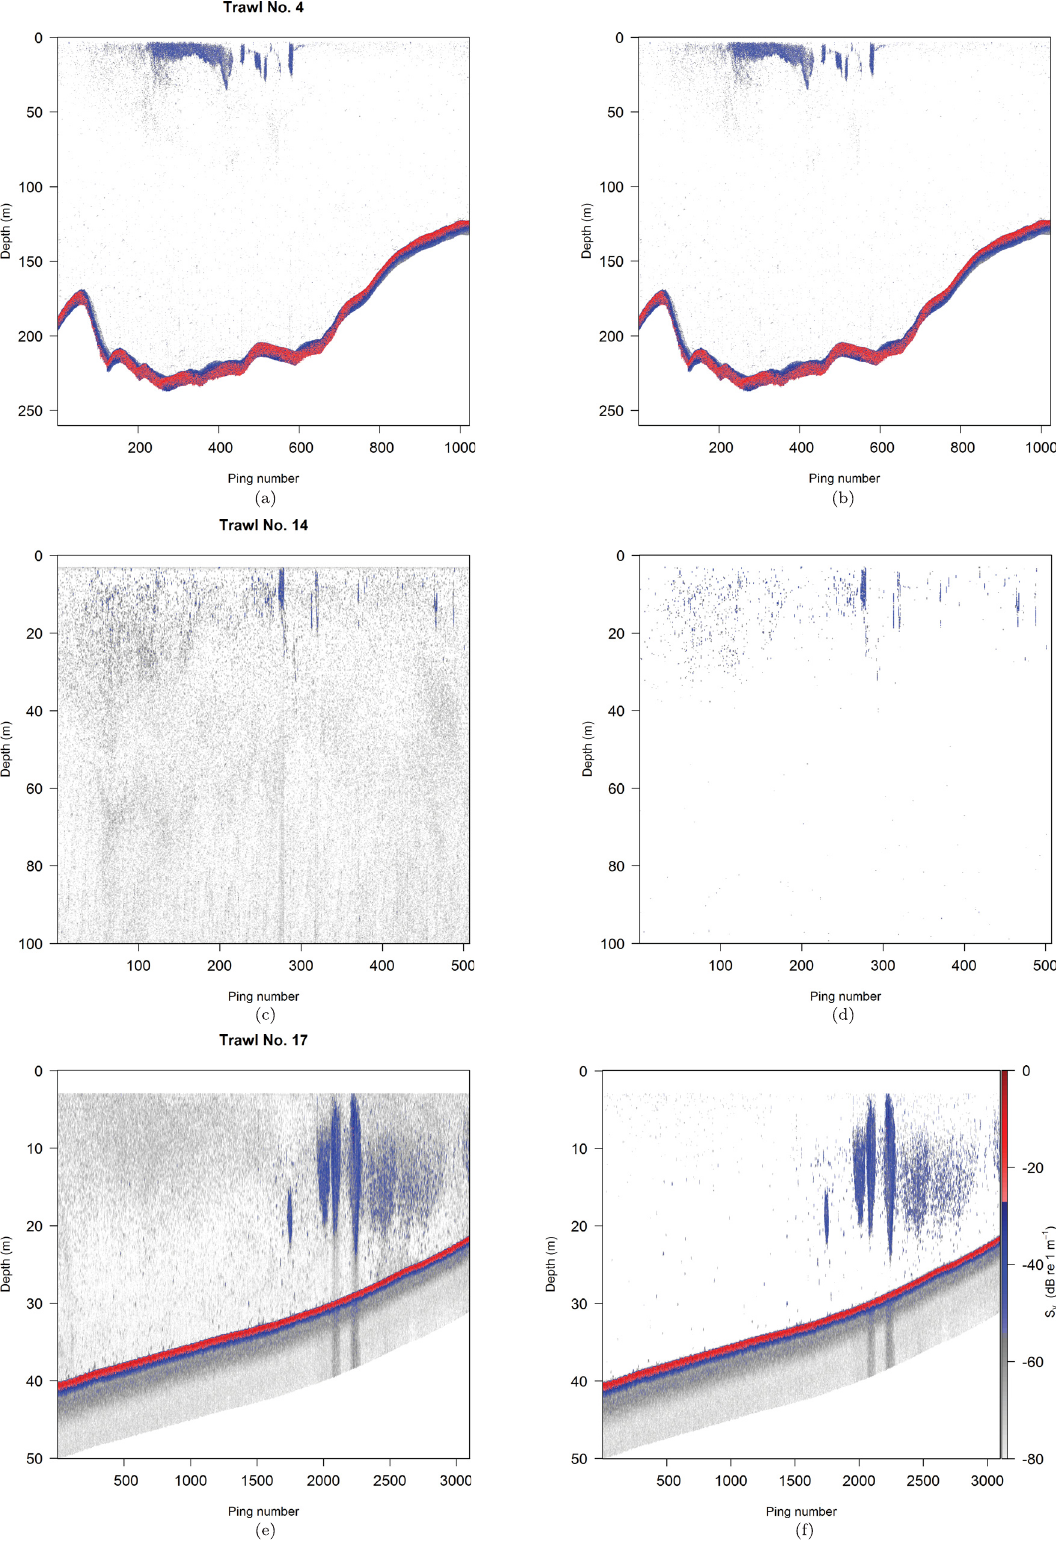
Fig. 4. Examples of echograms associated to fi shing hauls with small pelagic fi sh catches. (a) and (b) are, respectively, the thresholded versions of the raw echogram in Figure 1a using (cid:1) 60.4 (from Fig. 2f) and the optimal (cid:1) 59.4dB estimated from the raw S v samples. (d) and (f) are the thresholded versions of (c) and (e) using a (cid:1) 59.4dB threshold. The colour scale is the same for all